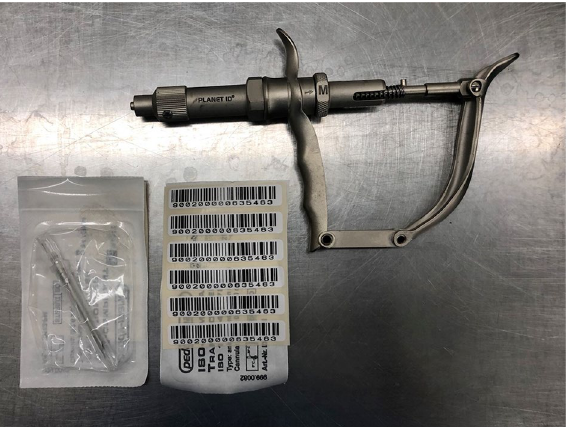
Figure 2. RFID Injection gun. Injection gun with a special needle containing the coded RFID which is implanted in the mice’ subcutis.